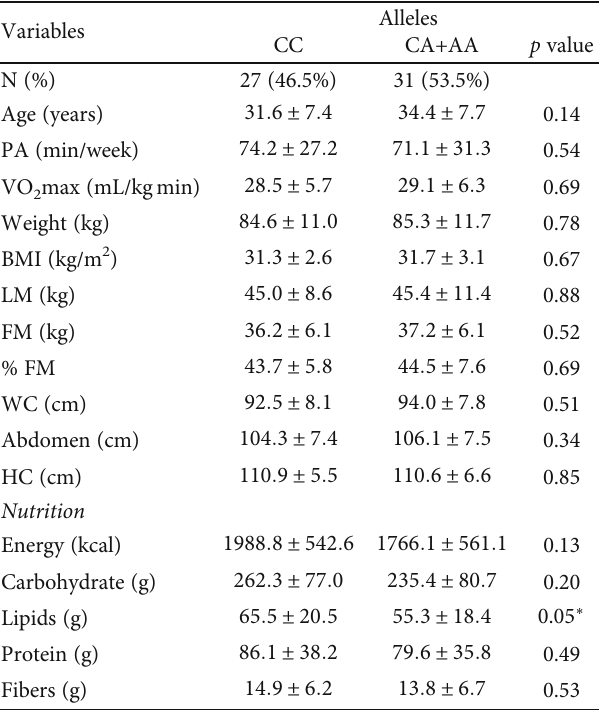
Table 2: Baseline characteristics of participants according to the 7 G/C (rs 4253778) polymorphism of the PPAR α